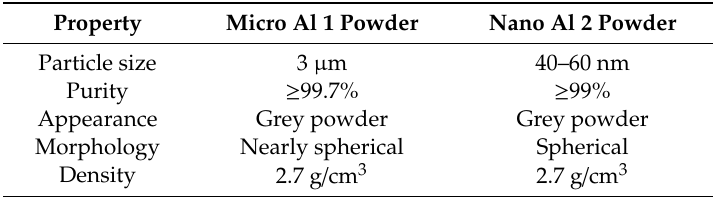
Table 1. Physical properties according to the data sheets of the Aluminum micro and nano powders from Nanokar,